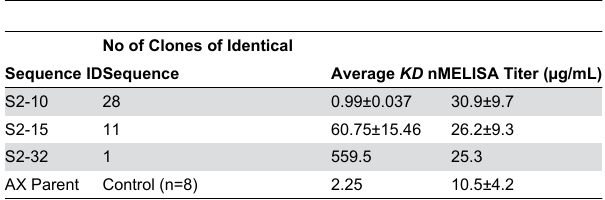
Table 2. Analysis of anti-PCSK9 variants following 2 nd round of enrichment.